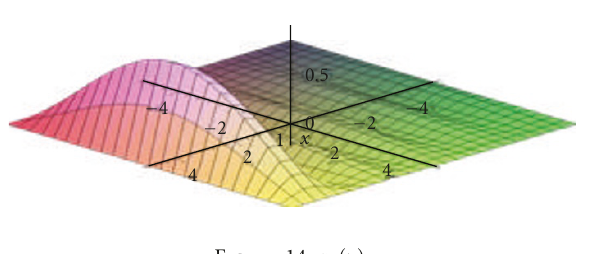
Figure 14: ϕ 5 ( z ).